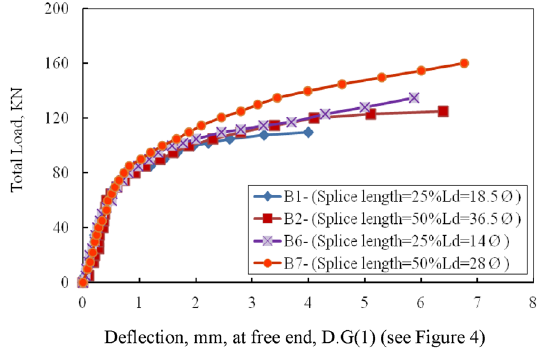
Fig. 13 Load–deflection curves for Beams B1, B2, B6 and B7